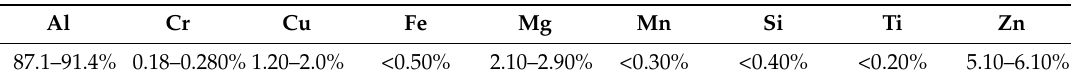
Table 1. Chemical composition of the Al 7075